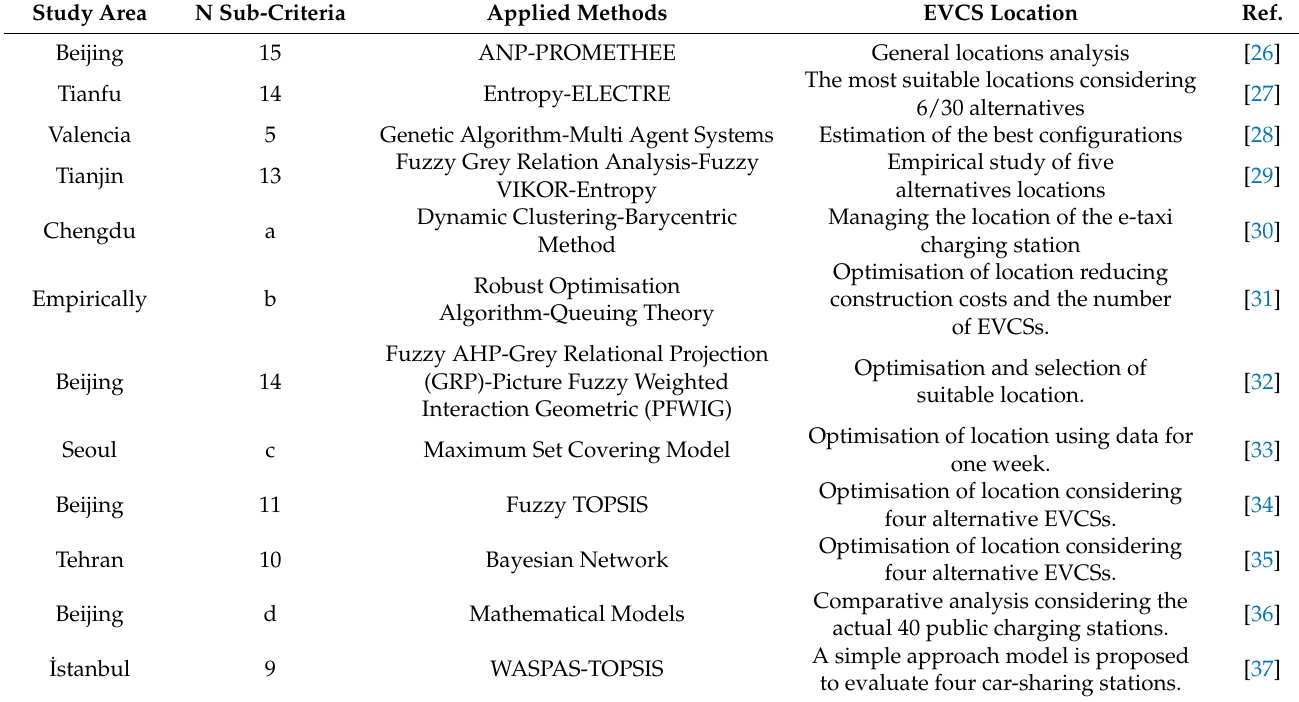
Table 1. Overview of site selection studies on